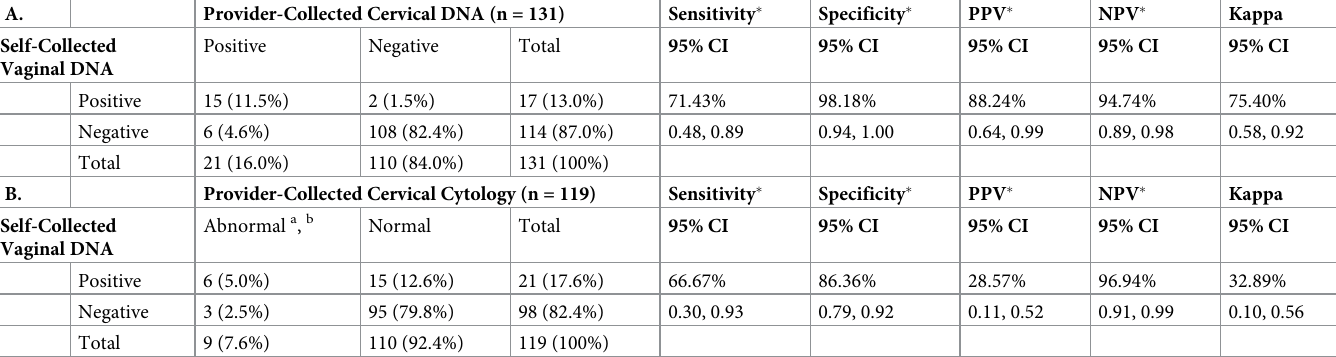
Table 3. Concordance of self-collected vaginal HPV DNA hybridization assay to the provider-collected cervical HPV DNA specimen and to the provider-collected cervical cytology.